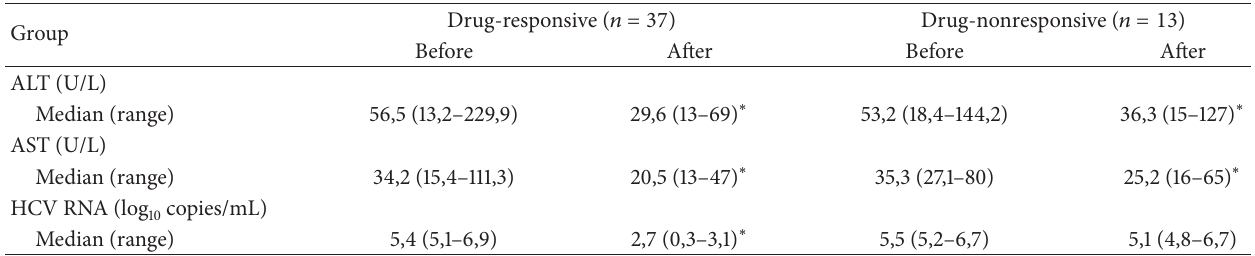
Figure 3: The expression of activation marker (CD86) in interferon responsive and nonresponsive HCV patients at baseline. A total of 50 HCV patients were treated with interferon for 2 weeks, and the frequency of CD86+ B cells in peripheral blood was determined by flow cytometry analysis at baseline: (a) the expression of the activation marker (CD86) on total (CD19+), plasma (CD19+CD38+), and nonplasma (CD19+CD38 − ) B cells stimulated with CpGB and (b) the expression of the activation marker (CD95) on total (CD19+), plasma (CD19+CD38+), and nonplasma (CD19+CD38 − ) B cells stimulated with CpGB + IL-2. Data were analyzed by the Wilcoxon rank-sum test. The horizontal lines indicate the median values of different groups. Data are expressed as mean % of individual samples from at least two separate experiments. Table 2: Effects of interferon treatment on clinical profiles of HCV